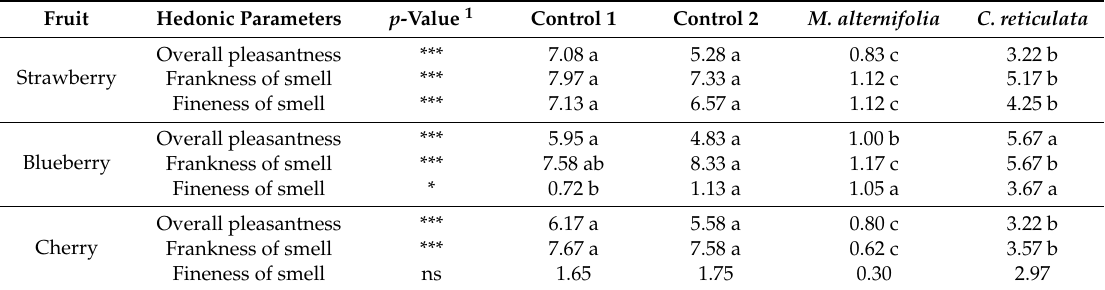
Table 6. Hedonic parameters of the sensory analysis ranked by panelists during the tasting of fruits treated with Citrus reticulata and Melaleuca alternifolia essential oils.